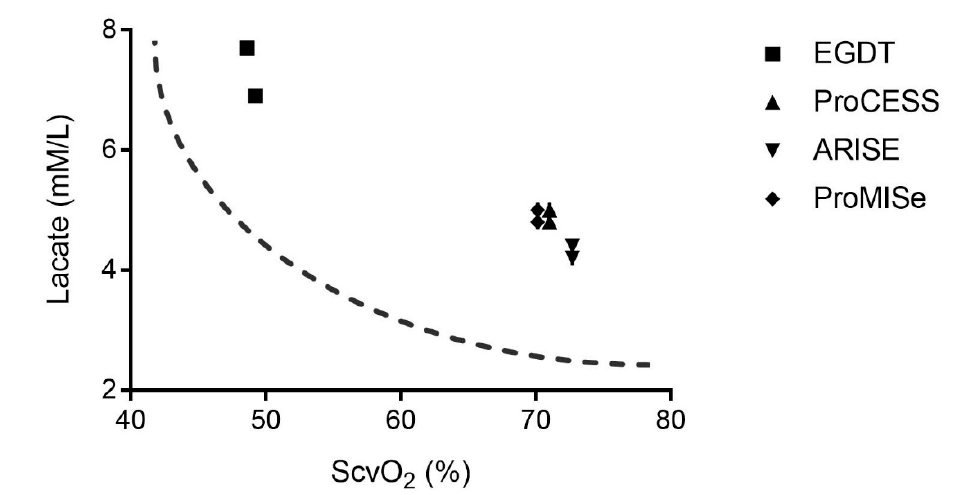
Figure 6. Comparing phenotypes (determined by ScvO 2 and lactate) of septic shock patients enrolled in studies comparing Early Goal-Directed Therapy (EGDT) versus usual care [76].